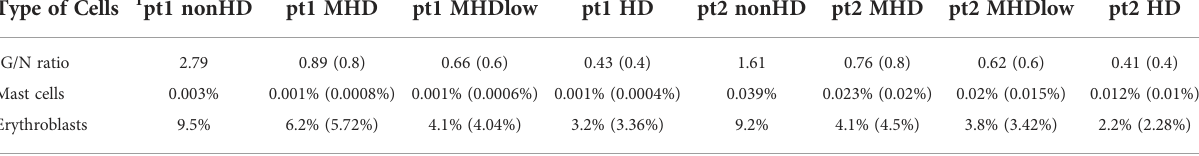
TABLE 4 Changes in the composition of BM cell populations in serial hemodilution experiments. Distribution of parameters used in the ALLgorithMM to de fi ne hemodilution of BM samples, within 4 different scenarios simulated for each patient: nonHD (sample as it is), MHD (sample diluted with PB to obtain an MHD sample), MHDlow (sample diluted with PB to obtain an MHD sample nearly HD), and HD (full hemodiluted sample). In parentheses are represented in silico -derived values, as expected by applying serial dilutions of samples to simulate the 4 different